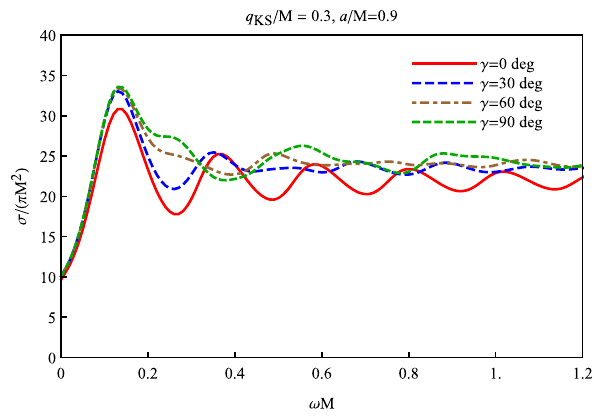
Fig. 5 TotalabsorptioncrosssectionofaKSblackholewith q KS / M = 0 . 3 and a / M = 0 . 9 for different values of the incidence angle